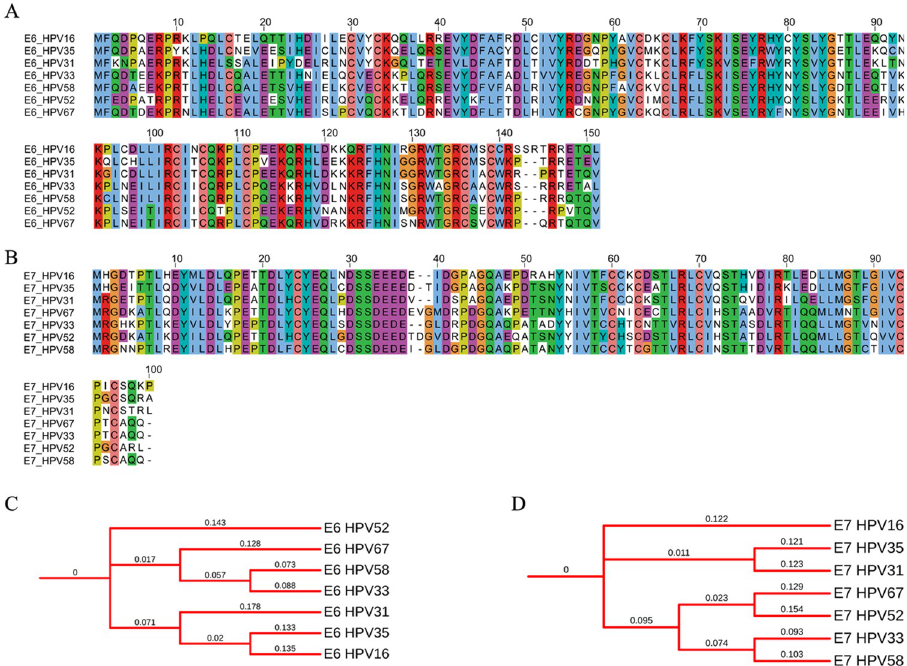
Fig 6. Phylogenetic profile of E6 and E7 oncoproteins from HPV. (A) Multiple sequence alignment of E6. (B) Multiple sequence alignment of E7. (C) Phylogenetic tree of E6 and (D) E7 oncoproteins.